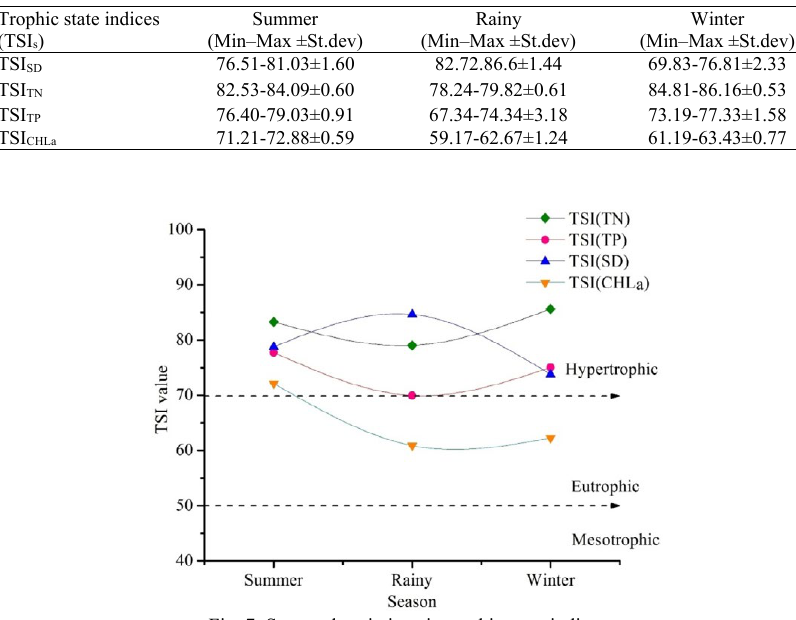
Fig. 7: Seasonal variations in trophic state indices